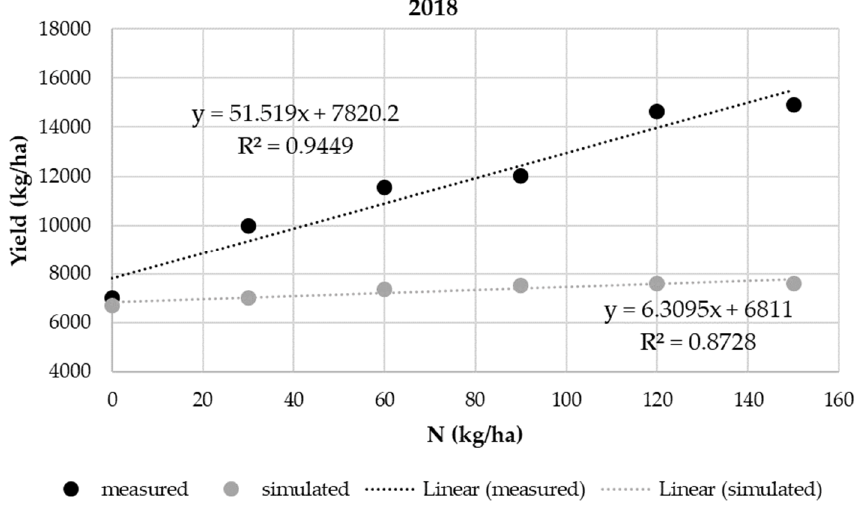
Figure 4. Comparisons between simulated and measured maize grain yield (2018).